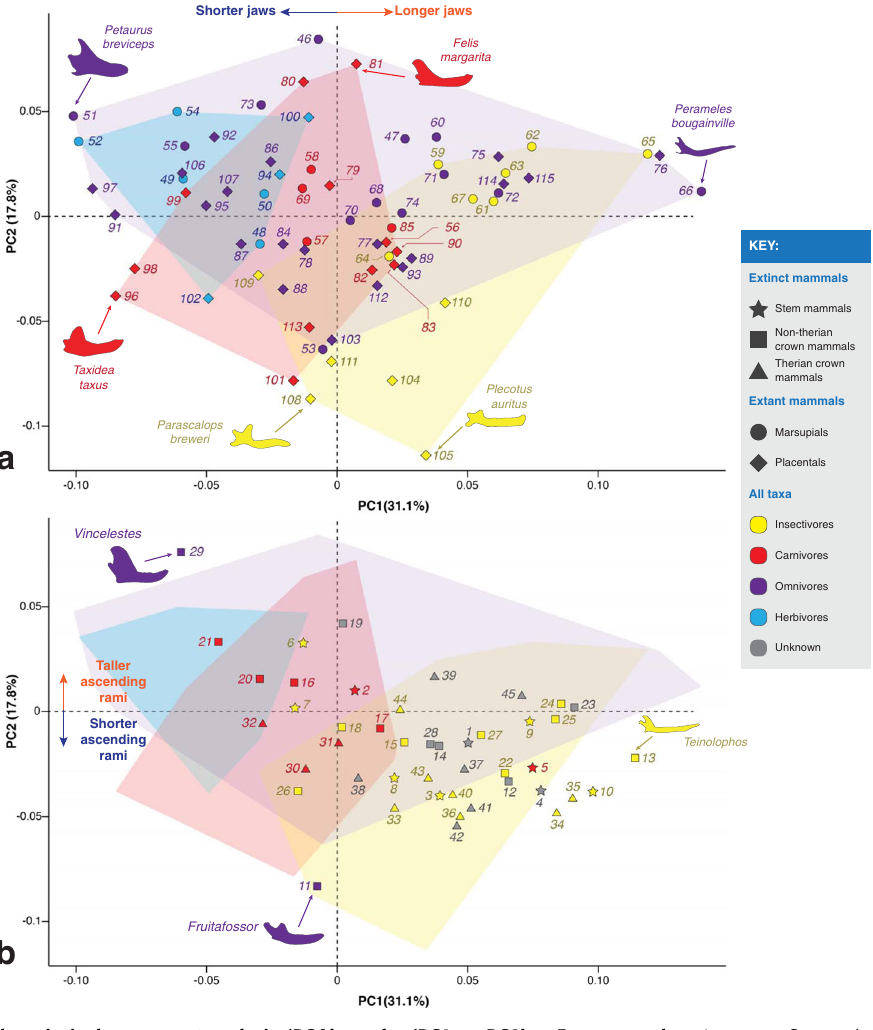
Fig. 3 Scatter plots of the principal component analysis (PCA) results (PC1 vs. PC2). a Extant taxa, b extinct taxa. Convex hulls shown for extant insectivores (yellow), carnivores (red), omnivores (purple) and herbivores (blue). Icon colors indicate known dietary categories of extant mammals and suggested dietary categories for Mesozoic mammals (obtained from the literature). See Table 1 for taxon names.